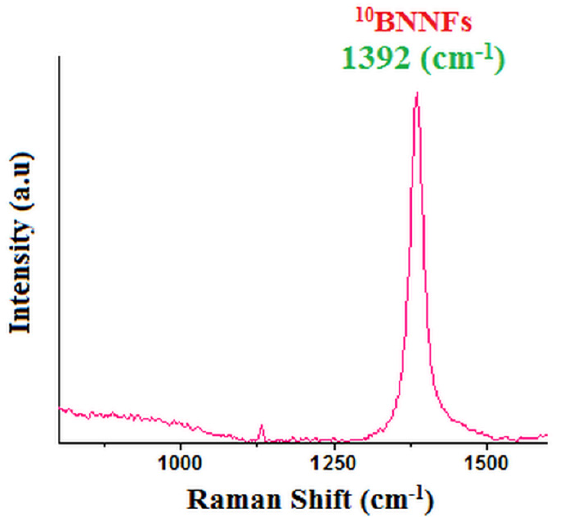
Figure 5. The spectrum shows a high-intensity peak in the displayed Raman spectrum at 1392 (cm − 1 ) for the synthesized 10 BNNFs sample.